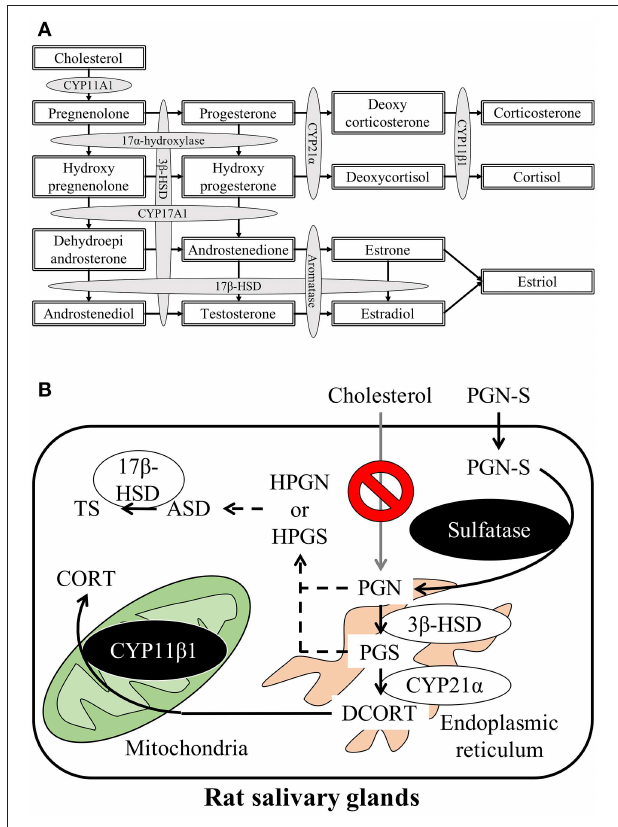
FIGURE 1 | (A) Schematic representation of the steroidogenesis pathway. Steroidogenesis involves cytochrome P450 reactions and hydroxysteroid dehydrogenase reactions. (B) Schematic illustration of the steroid synthesis pathway in rat salivary glands. Pregnenolone sulfate (PGN-S) in the blood is taken up by the salivary glands and then converted to pregnenolone (PGN) by the enzyme sulfatase. De-conjugated PGN functions as a precursor for the local corticosterone (CORT) or testosterone (TS) synthesis